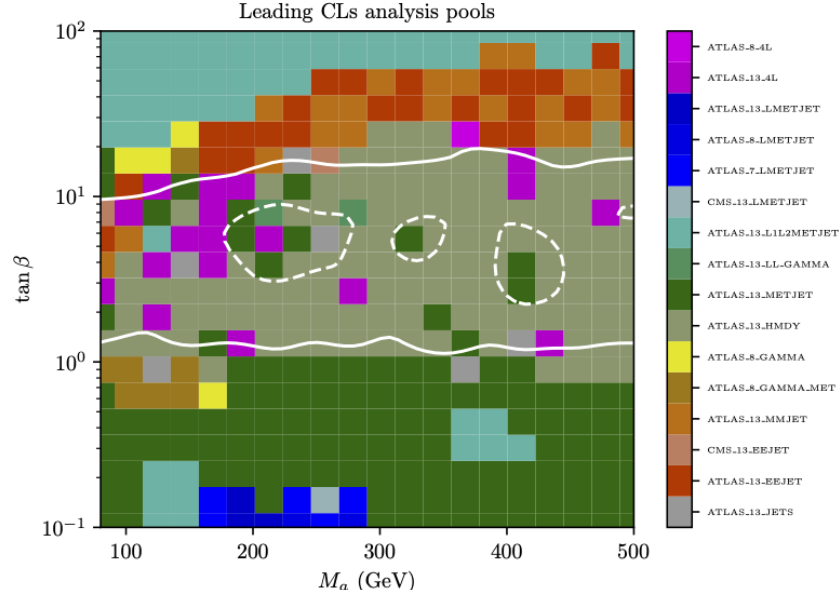
Figure 3: Discontinuities in the dominant analysis pools from the Two Higgs-Doublet Dark Matter Model with Pseudoscalar Mediator. The solid and dashed white lines rep- resent the true 68% and 95% CL contours exctracted from C ONTUR while the colours represent the “dominant ananlysis pool”: type of analysis (in orthogonal pools of ex- periment, center-of-mass energy and final state) which gave the best standalone ex- clusion. The fact that the dominant analysis pool shows discontinuities, linked to the phenomenology of the model under study, which are closely linked to the positions of the exclusion contours, shows that a classifier based on the parameters of a model can be used to extract information such as the exclusion status of a